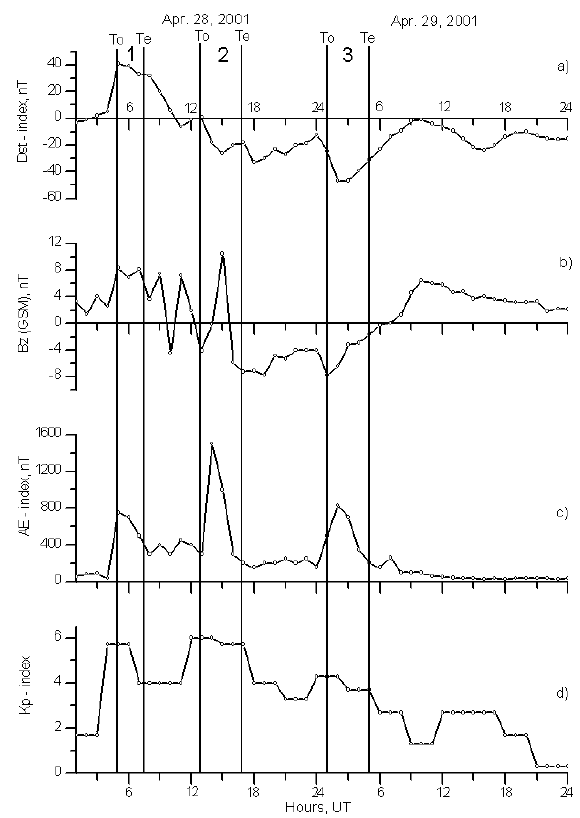
Fig. 2. Variations of geophysical parameters during a magnetic storm on 28–29 April 2001, ( a ) D st -index, ( b ) B z -component of the interplanetary magnetic field, ( c ) AE-index, and ( d ) K p . The three substorms that occurred during this period are marked by ver- tical lines and indicated as 1, 2, and